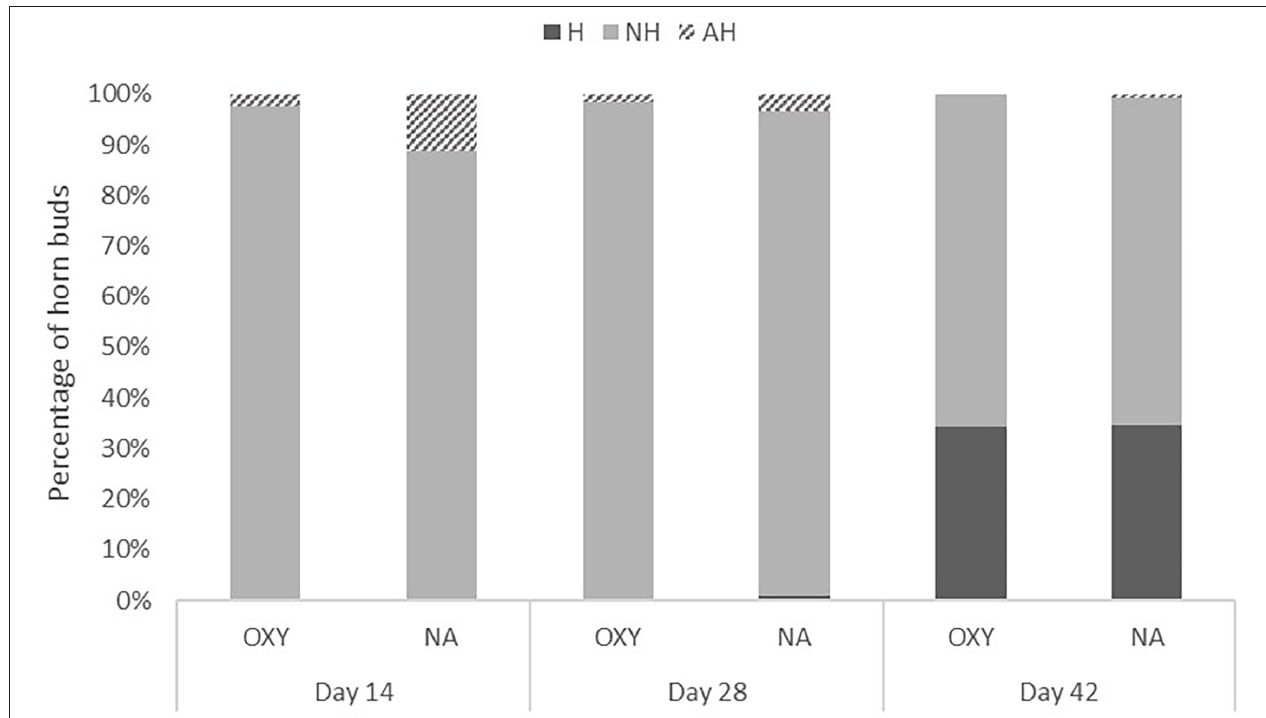
FIGURE 3 | Prevalence of lesion scores (LS) by study groups (OXY vs. NA). H, healed; NH, normal healing; AH, abnormal healing at 14, 28, and 42 days post disbudding.